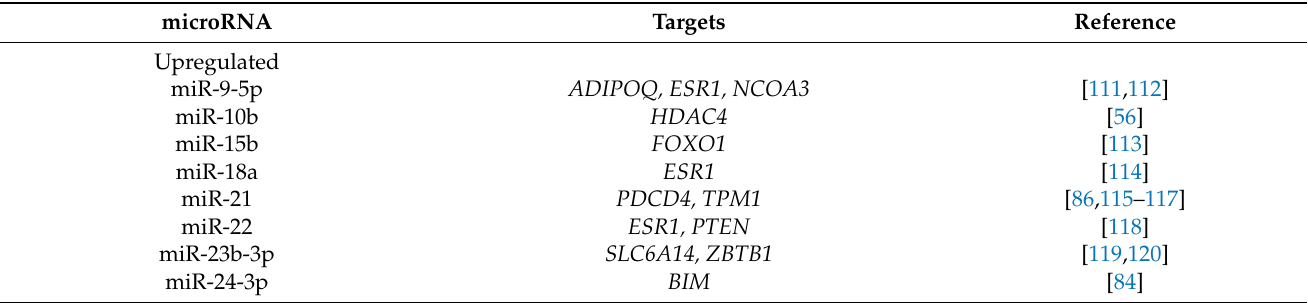
Table 1. microRNAs associated with